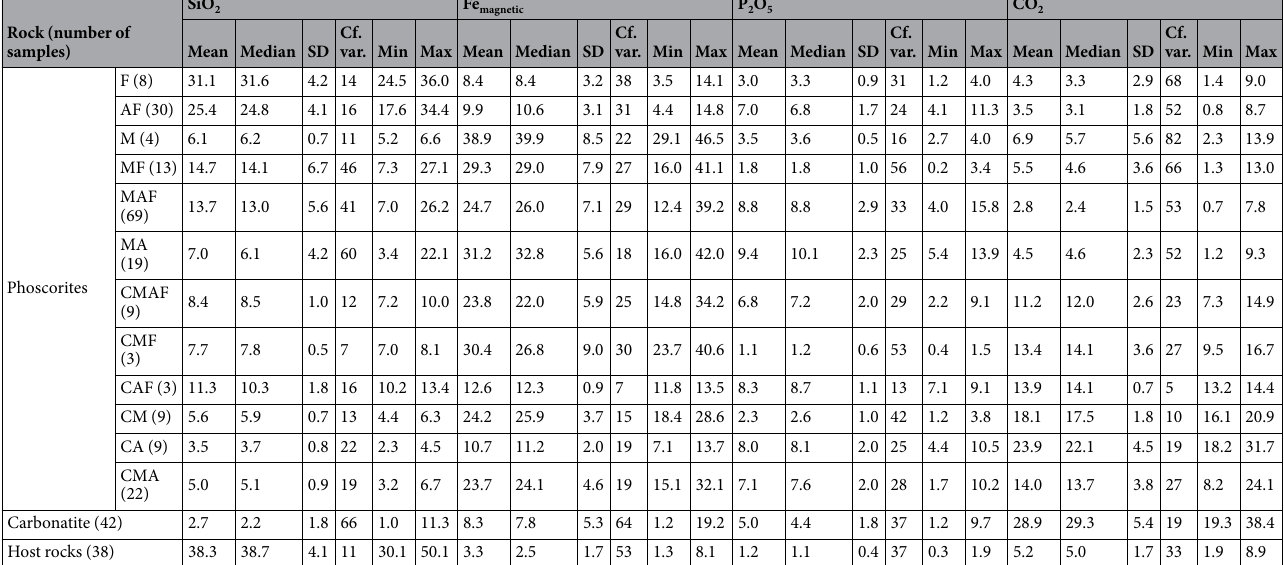
Table 1. Statistical parameters of components used for automatic 3D geological mapping, wt. %. SD is standard deviation. Cf. var. is coefficient of variation. Letters C, M, A, F are mineral indexes in phoscorite name: calcite, magnetite, apatite and forsterite, correspondingly (classification is shown in Fig.